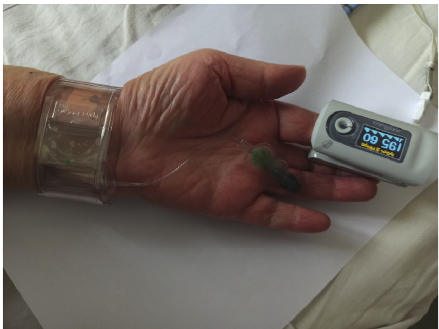
Figure 3: Compression of the ulnar artery with TR band with radial flow restoration (the appearance of plethysmographic